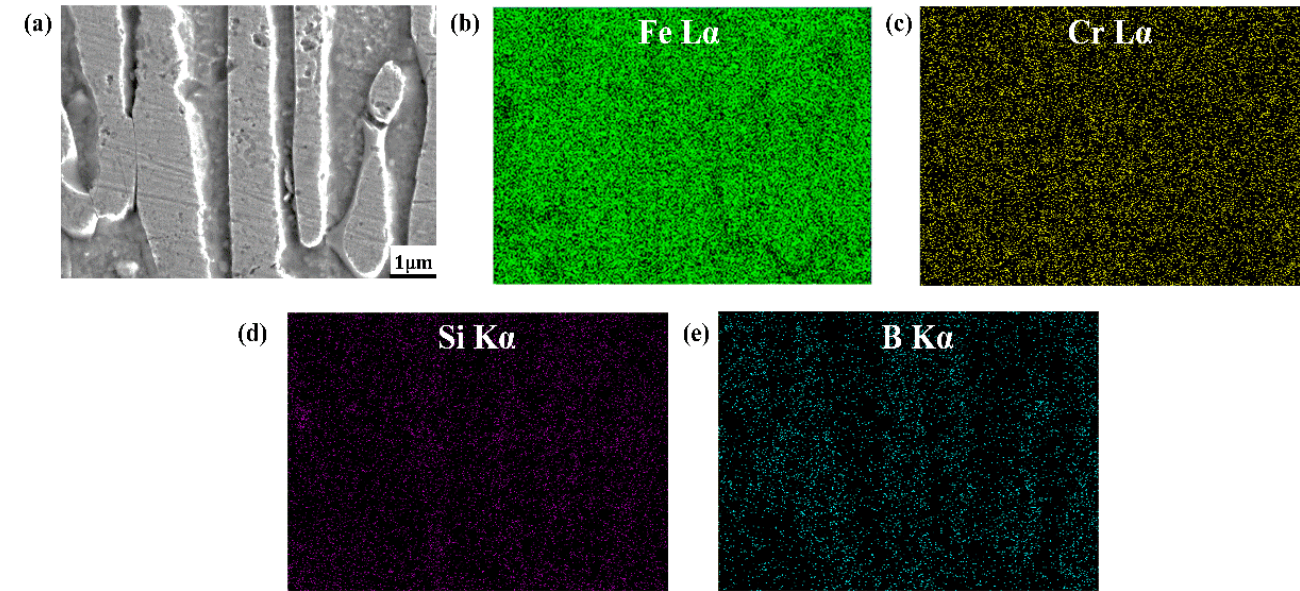
Figure 6. The EDS maps of A1 DS Fe-B alloy: ( a ) micrograph of surface scanning, ( b ) element distribution of Fe, ( c ) element distribution of Cr, ( d ) element distribution of Si, ( e ) element distribution of B.